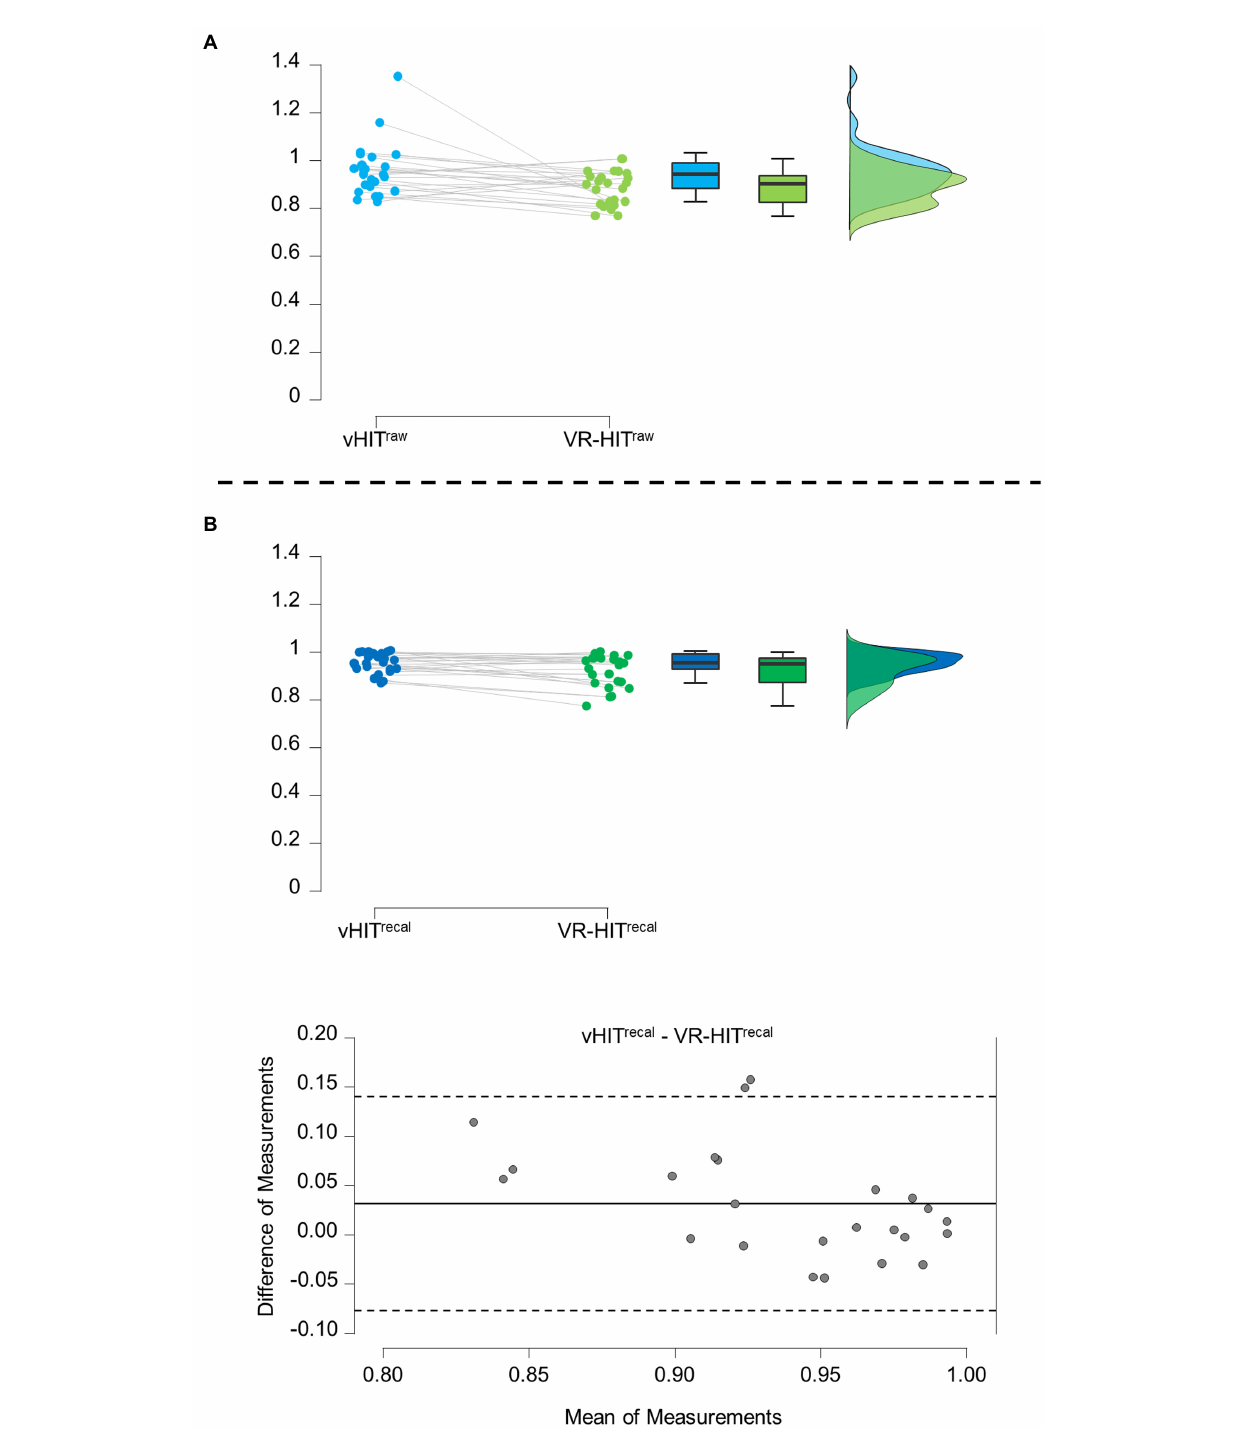
FIGURE 5 (A) VOR gain comparison between VR-HIT and vHIT for raw VOR (VORraw). Raincloud plot of VOR gain for vHIT (blue) and VR-HIT (green) during normal condition. The box plots show, from bottom to top, the lower extreme (excluding outliers), 1st quartile, mean, 3rd quartile, and upper extreme (excluding outliers). (B) VOR gain comparison between VR-HIT and vHIT for recalibrated VOR (VORrecal). Raincloud plot as described above and Bland–Altman plot are shown. In the Bland–Altman plot the mean difference is indicated by the solid line and the upper and lower 95% limits of agreement are indicated by the dashed